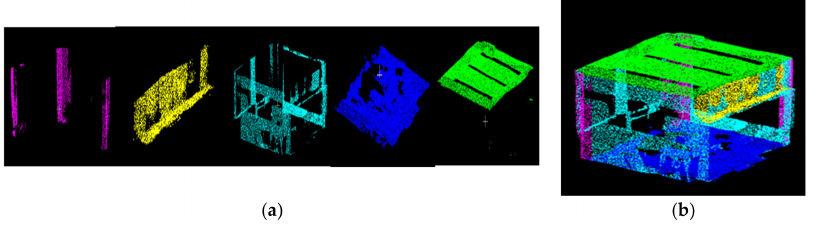
Figure 2. ( a ) Classification results for each category (from left to right: column, beam, wall, floor, ceiling). ( b ) Combination of all classification